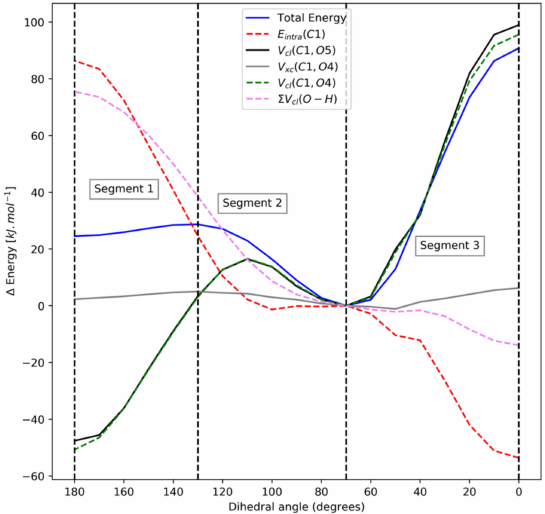
Figure 6. Individual and total energy profiles of the most important contributors over the 3 segments in DMM supplemented with V xc